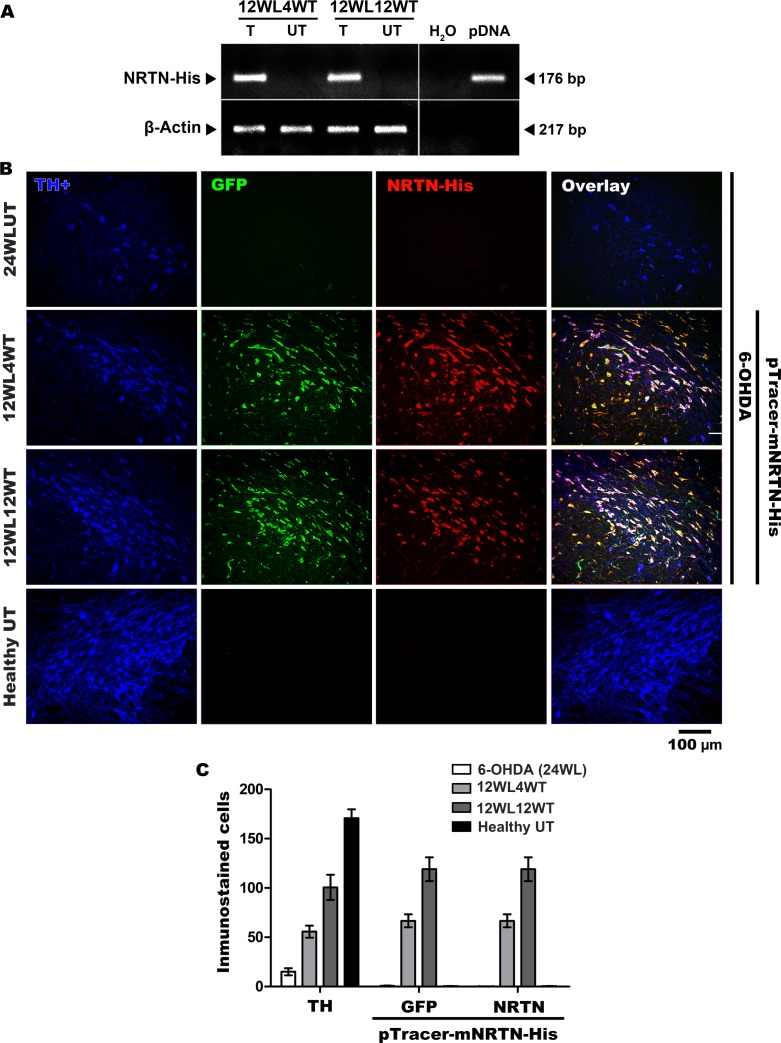
NRTN-His expression in the substantia nigra of rats with chronic 6-OHDA lesion.A. Representative agarose gel showing the amplicons for NRTN-His and β-actin after a RT-PCR assay. Internal controls in the absence (H2O) and presence of pTracer-mNRTN-His (pDNA). B. Representative micrographs of triple immunofluorescence assays against TH, the rate limiting enzyme in DA synthesis [53], green fluorescent protein (GFP) and His epitope (NRTN-His). C. Number of immunostained transfected cells. Intranigral transfection of the plasmid pTracer-mNRTN-His, which codes for NRTN-His and GFP, was made at week 12 after lesion. 12WL4WT = 12 weeks after lesion and 4 weeks after transfection. T = transfected side. UT = Untransfected side of the same rat. 12WL12WT = 12 weeks after lesion and 12 weeks after transfection. The scale bar is common for all micrographs.